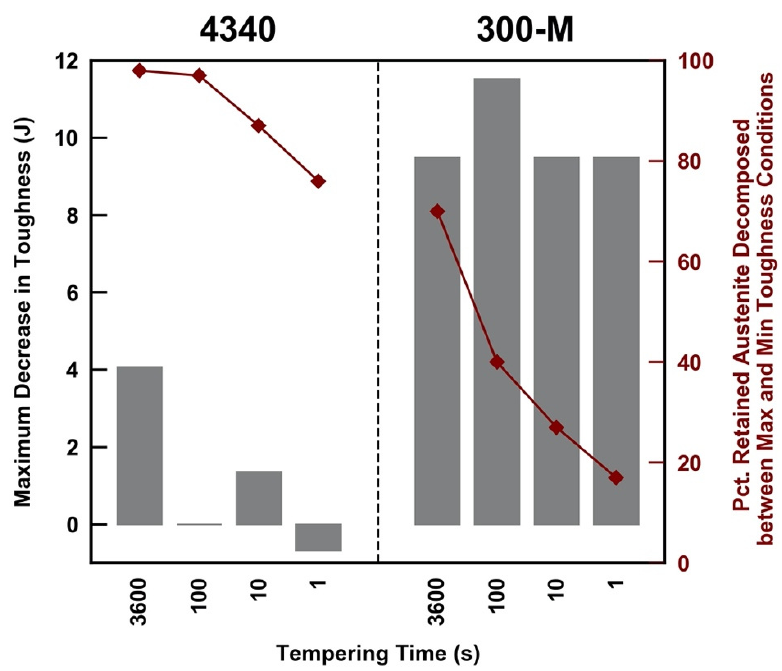
Figure 5. Comparison of TME severity between 4340 and 300-M tempering conditions represented as the maximum decrease in toughness (bars) with increased tempering. Corresponding retained austenite decomposition levels (symbols + lines) are displayed with respect to the maximum and minimum toughness conditions used in determining the maximum decrease in toughness. The negative value represented for the 4340—1 s condition indicates that there is no measured decrease in toughness for this time condition. The tempering conditions evaluated are thus associated with the smallest increase in toughness (plateau) within the TME regime for the 4340—1 s